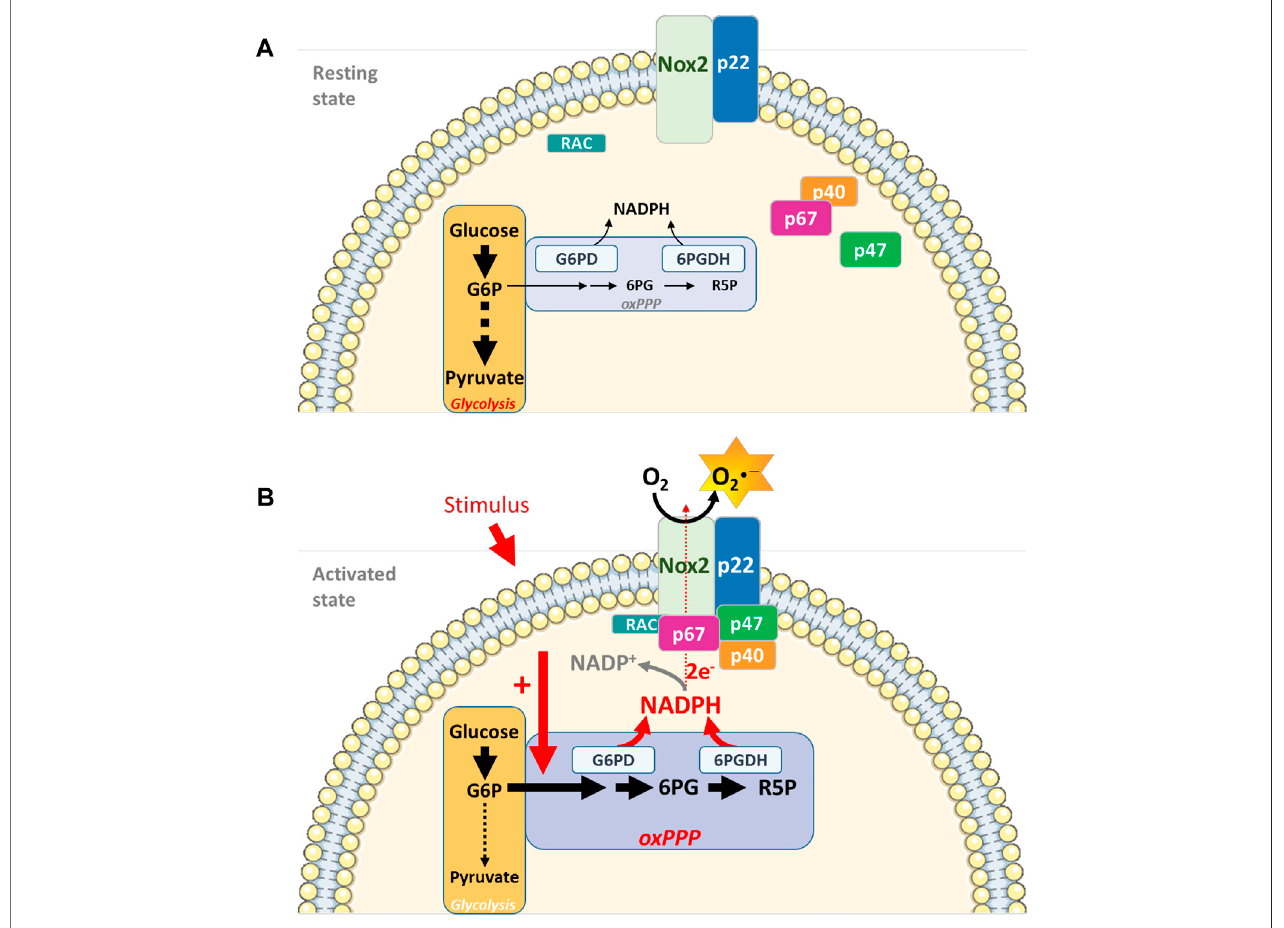
FIGURE1| InterconnectingcellmetabolismandNOX2activityinneutrophils. (A) .Inrestingneutrophils,energymetabolismdependsessentiallyonglucoseandon theglycolyticpathwayforATPproductionandenergysupply.NOX2isdissociatedandinactive. (B) .Uponcellstimulation(PMA,opsonizedbacteria,fMLP),theoxidative phaseofthePPPisactivated, leadingtoanincreaseinNADPHconcentration,alimitingcofactorforNOX2complexactivity.Micro-compartmentationcouplingenzymes involved in the energy metabolism (G6PD and 6 PGDH) and NOX2 complex represent an additional level of NADPH oxidase activity regulation (G6P: Glucose-6- Phosphate; 6 PG: 6-PhosphoGluconate; R5P: Ribulose-5-Phosphate) Parts of this fi gure were drawn by using pictures from Servier Medical Art. Servier Medical Art by Servier is licensed under a Creative Commons Attribution 3.0 Unported License (https://creativecommons.org/licenses/by/3.0/).